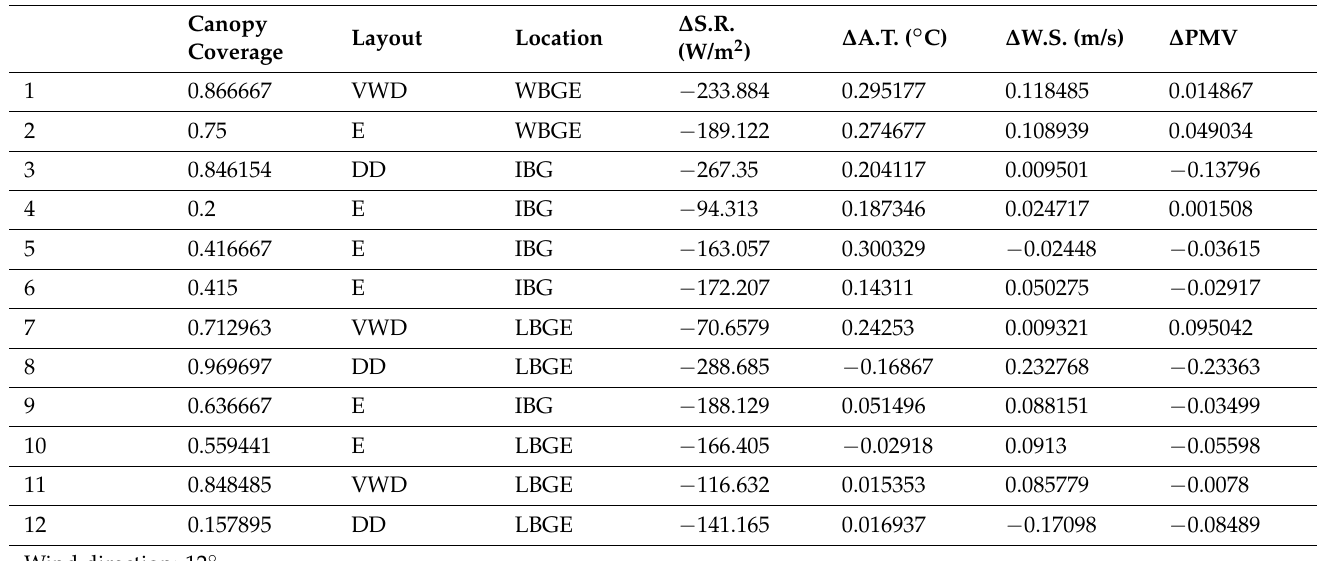
Table A1. Average comparison values in microclimate and comfort for the 12 marquees on four